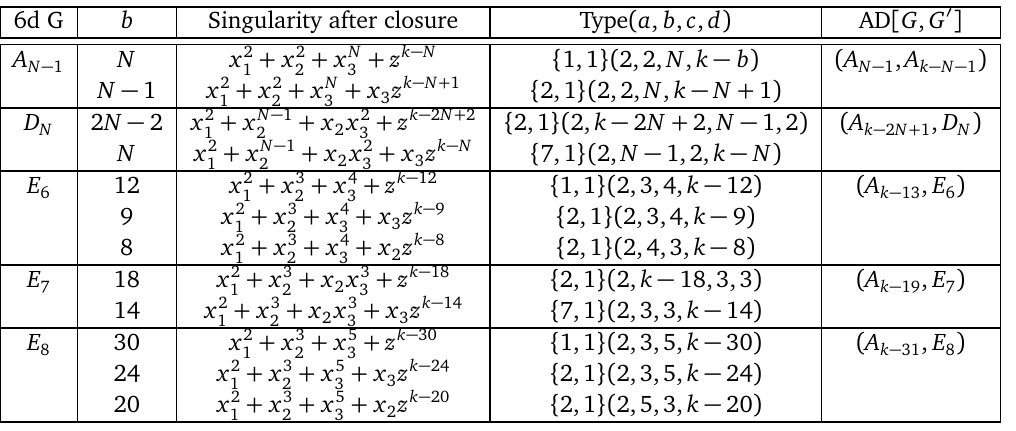
Table 2: Untwisted irregular punctures of IHS type and their hypersurface